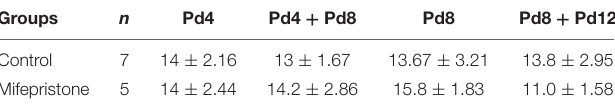
TABLE 1 | The effect of mifepristone on the litter size. Pd4, mice were treated with 1, 3-propanediol or mifepristone on Pd4; Pd4 + Pd8, mice were treated with 1, 3-propanediol or mifepristone on Pd4 and Pd8, respectively; Pd8, mice were treated with 1, 3-propanediol or mifepristone on Pd8; Pd8 + Pd12, mice were treated with 1, 3-propanediol or mifepristone on Pd8 and Pd12,